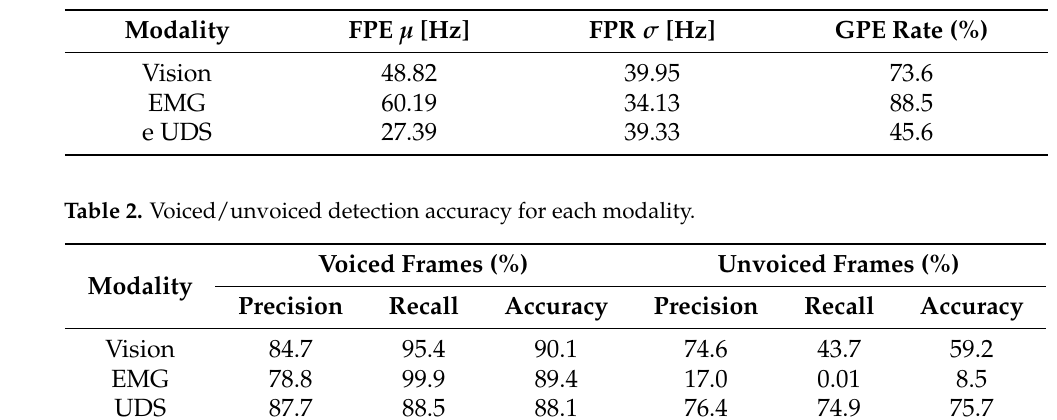
Table 1. Pitch estimation accuracy for each modality.